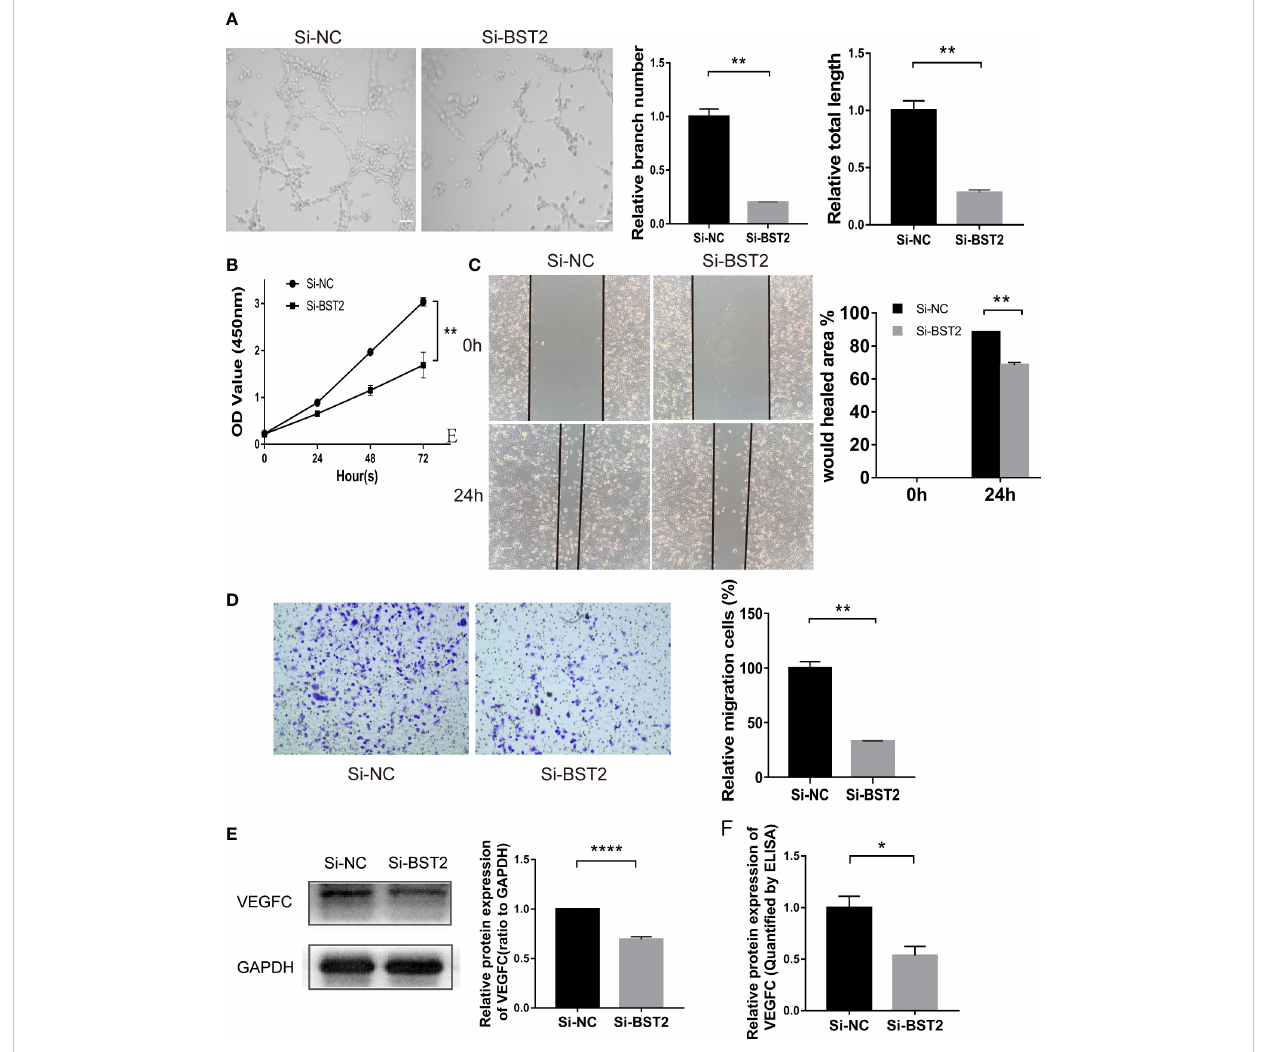
FIGURE 5 Effect of the conditioned medium (CM) of EESCs with BST2 knockdown on HLECs. (A) , The Tube formation assay was conducted to check the tube formation ability with the CM of EESCs with BST2 knockdown on HLECs. (B) , CCK-8 assay showing the proliferation of HLECs treated with CM from Si-BST2 or Si-NC EESCs for 24h. (C, D) , Scratch assay (C) and transwell assay (D) were conducted to assess migration ability of HLECs treated with CM from Si-BST2 or Si-NC EESCs for 24h. (E) , The VEGFC protein expression was measured by western blot analysis after transfection with Si-BST2 or Si-NC for 48h. (F) , The VEGFC expression from the conditioned medium (CM) of EESCs with BST2 knockdown was detected by ELISA assay. *p < 0.05; **p < 0.01; ****p <